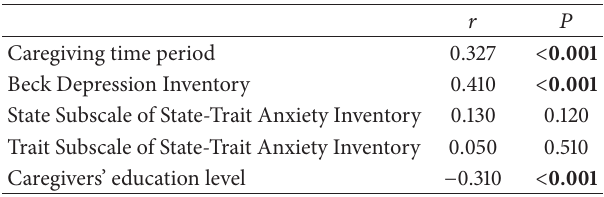
Table 3: Correlation analysis of caregiver burden with sociodemo- graphic data and psychiatric clinical